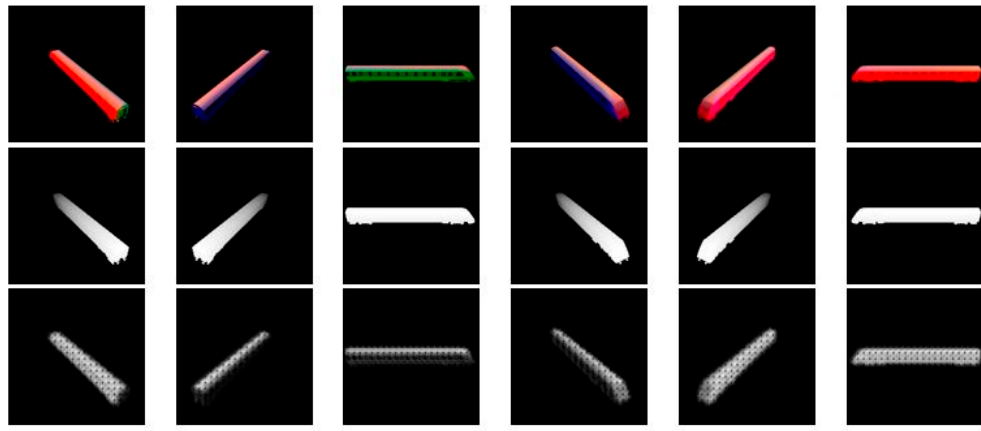
Figure 5. The results using a new train model. The top line shows the test images, the middle line shows the ground truth of each image, and the bottom line shows the depth our network predicts.